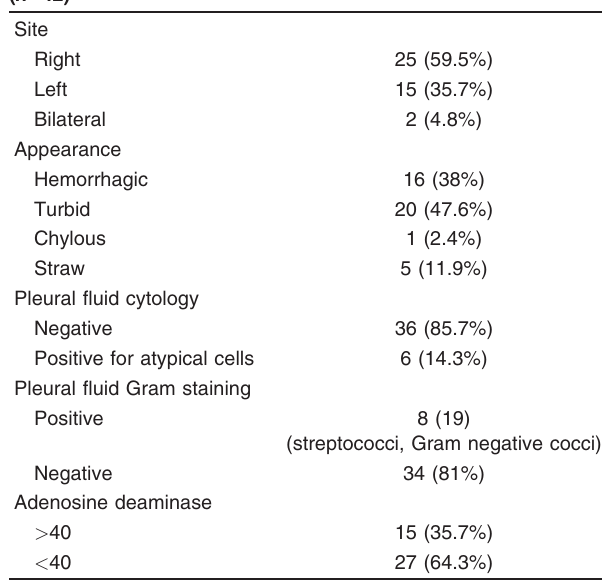
Table 3 Pleural fluid characteristics of the involved patients ( n = 42)